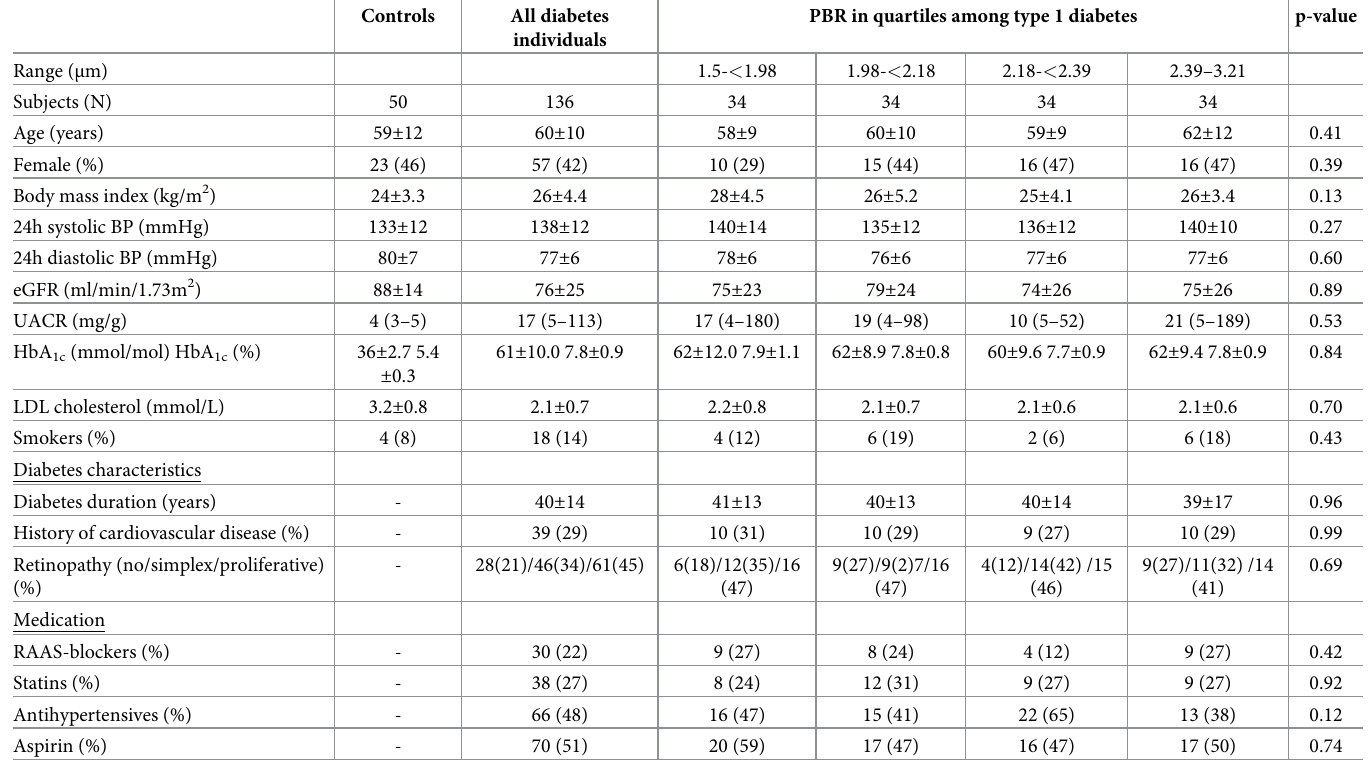
Table 1. Clinical characteristics of healthy controls, persons with type 1 diabetes and across quartiles of PBR among the persons with type 1 diabetes.